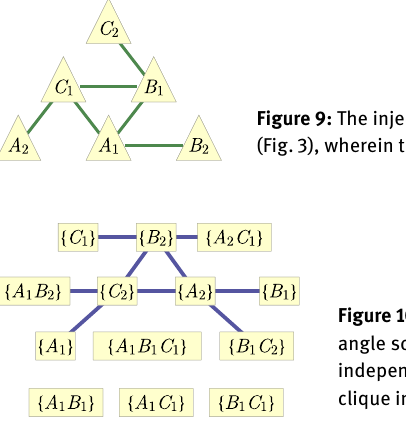
Figure 10: The ai-expressibility graph corresponding to the Spiral inflation of the Tri- angle scenario (Fig.3), wherein two injectable sets are adjacent iff they are ancestrally independent. A set of nodes is ai-expressible iff it arises as a union of sets that form a clique in this